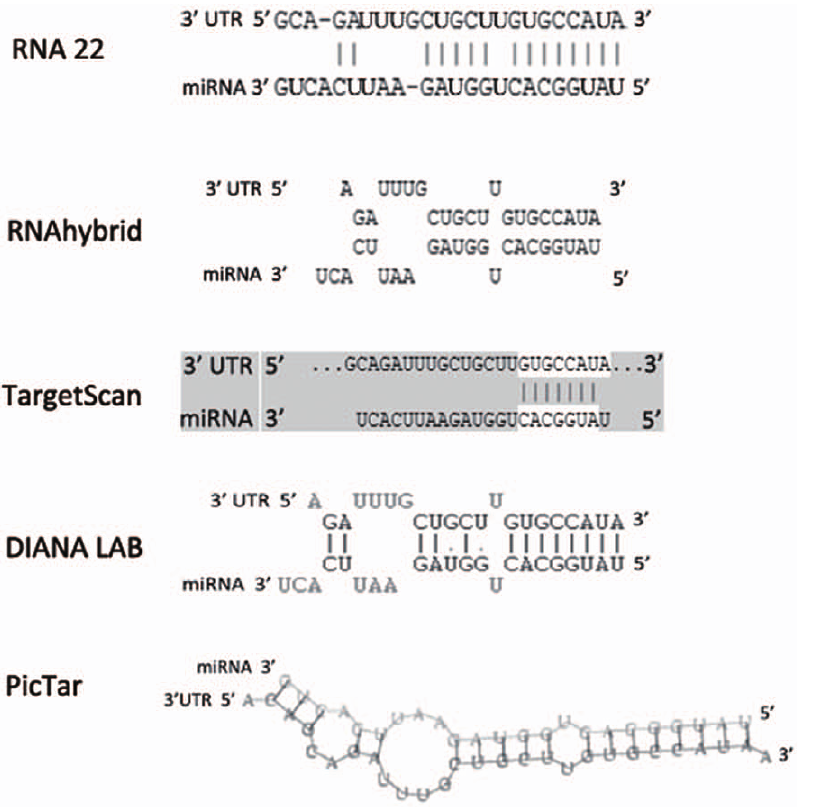
Figure 7. Potential miR-183- LRP6 interaction was predicted by algorithms RNA22, RNAhybrid, TargetScan, DIANA LAB and PicTar. We found putative binding site in 3 9 UTR of LRP6 , and the predicted results were identical among five different algorithms.